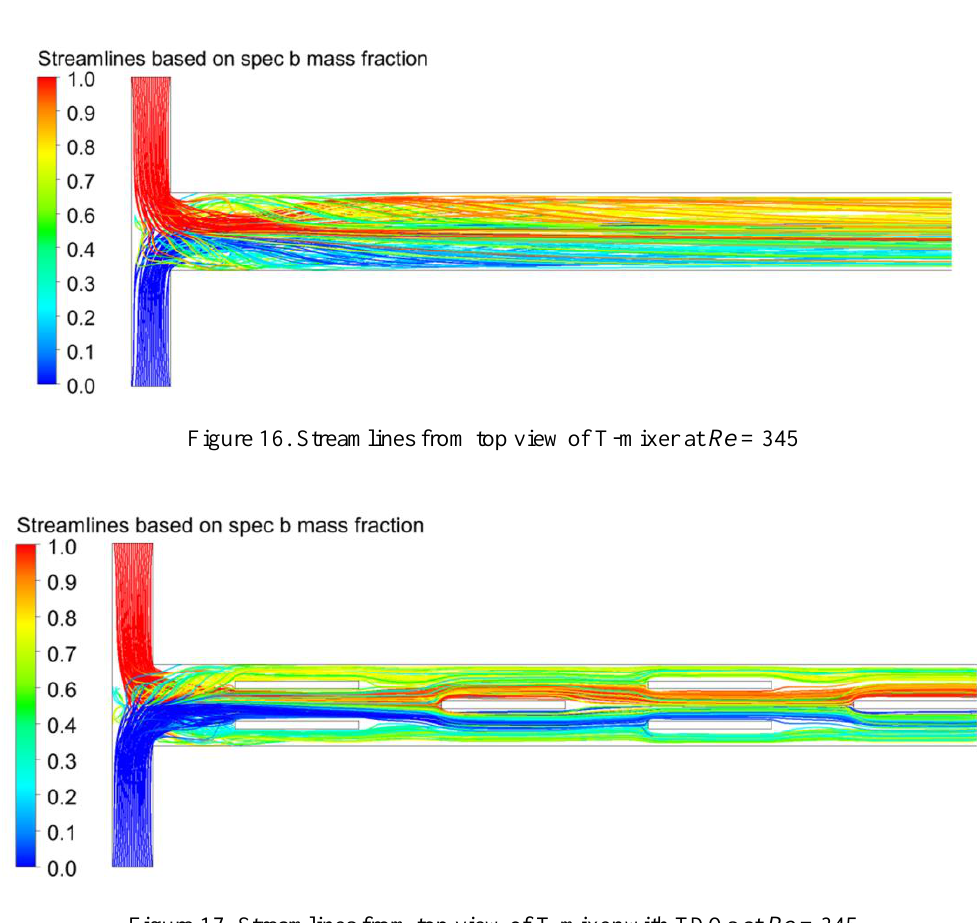
Figure 17. Streamlines from top view of T-mixer with TDOs at Re =